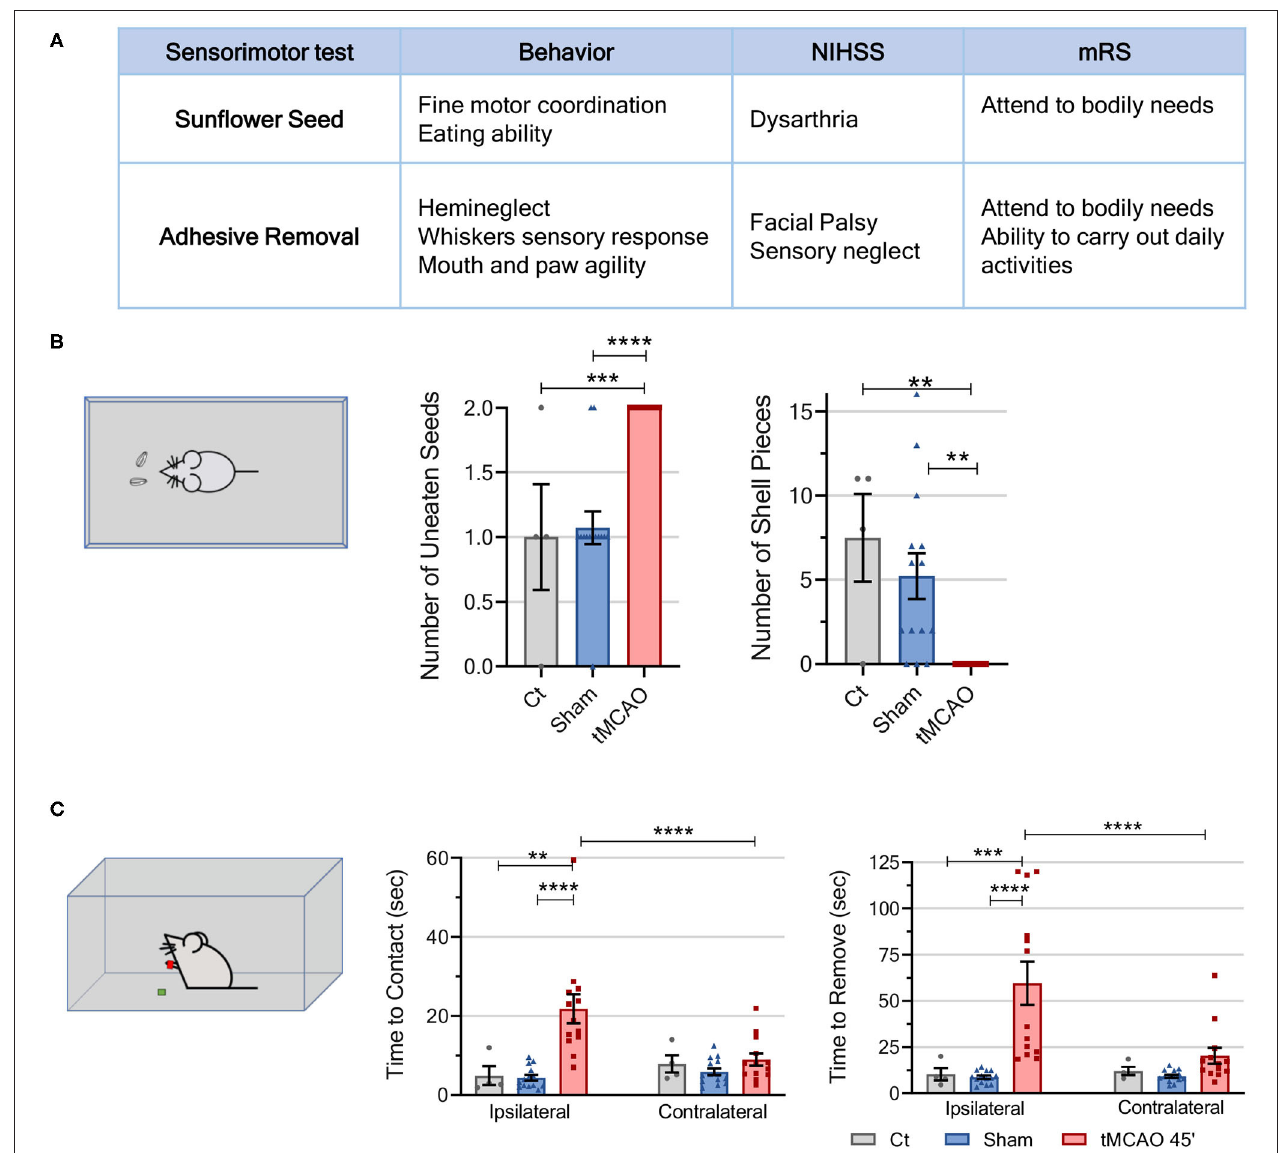
FIGURE 4 | Sensorimotor tests from the behavioral workflow display tMCAO’s sensorial and fine motor coordination deficits. (A) Table comparing the parameters evaluated in the sensorimotor tests to the scores assessed in human patients using the mRS and NIHSS. (B) Schematic representation of the sunflower seed challenge. The sunflower seed challenge allows for differentiation of sensory and fine motor impairments in stroke mice by evaluating the number of unopened seeds and shell pieces produced by the animals in a 30-min period of time [CT n = 4 (4 females), sham n = 14 (5 males and 9 females), tMCAO n = 14 (9 males and 5 females)]. (C) Schematic representation of the adhesive removal test. Sensorimotor deficits can be observed in the adhesive test through the time, in seconds, the mice take to make contact and remove the adhesive from either paw. A delay in sensing and making contact with the adhesive in the paw demonstrates sensorial deficiency, and the lingering time to remove it demonstrates facial palsy and more motor deficits [CT n = 4 (4 females), sham n = 14 (4 males and 10 females), tMCAO n = 13 (8 males and 5 females)]. **** p < 0.0001, *** p < 0.001, ** p < 0.01, * p < 0.05. One-way ANOVA or two-way ANOVA followed by Tukey’s multiple